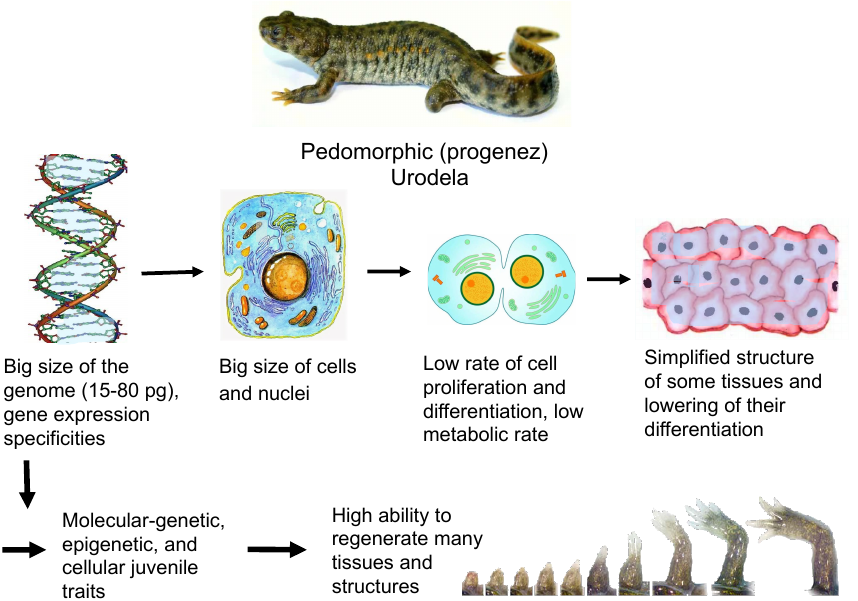
Figure 1. Features of Urodela associated with their high regenerative ability. Description presents in the